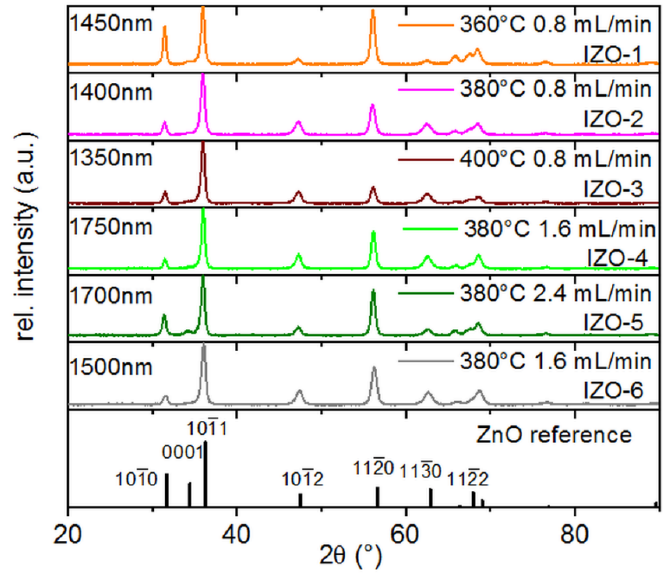
Figure 4. X-ray diffractograms for IZO films deposited with various temperatures/flow rates.